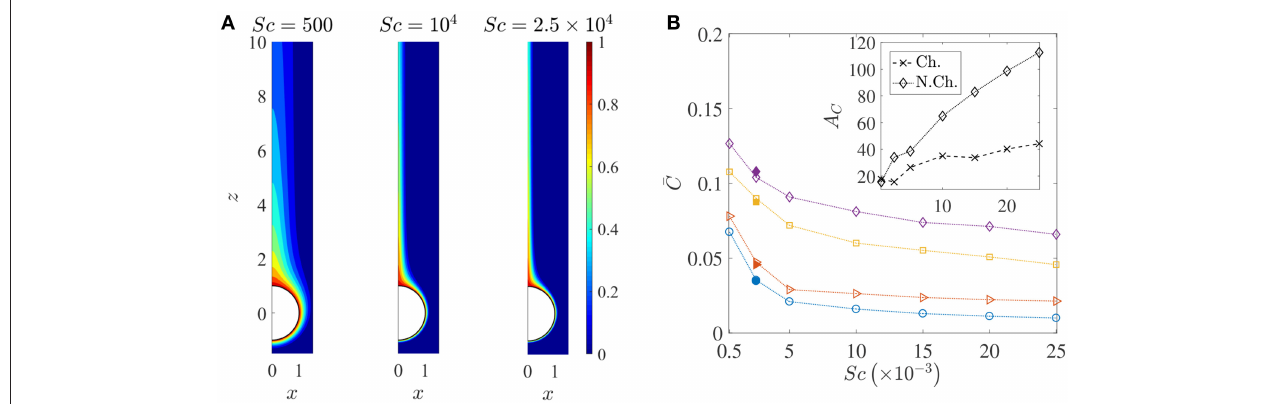
FIGURE 6 | (A) Spatial variation of the nutrient’s (normalized) concentration around the sinking sphere. The thickness of the concentration boundary layer, δ C , reduces as the nutrient diffusivity reduces. The corresponding values of the Péclet number are 100, 2000, 5000. In this figure, the distances are normalized by the radius of the sinking aggregate. (B) The variation in the average nutrient exposure, ¯ C , for chemotactic and non-chemotactic bacteria, with strong and weak hydrodynamic interactions, as a function of the Schmidt number. The legends in the main figure are as follows: 3 − chemotactic, α D = 2; 2 − chemotactic, α D = 0.1; (cid:3) − non-chemotactic, α D = 2; (cid:13)− non-chemotactic, α D = 0.1. The filled symbols (for Sc = 2500) correspond to simulation results with N b = 5000 bacteria, while the open symbols correspond to simulation results with N b = 1000 bacteria. Inset: The hydrodynamic amplification, A C , as a function of Sc , comparing separately the percentage increase in nutrient exposures for chemotactic and non-chemotactic bacteria (recall the definition of A C from Equation 7). The other parameters are: R = 45, K 1ρ = 0.0109, τ ∗ =